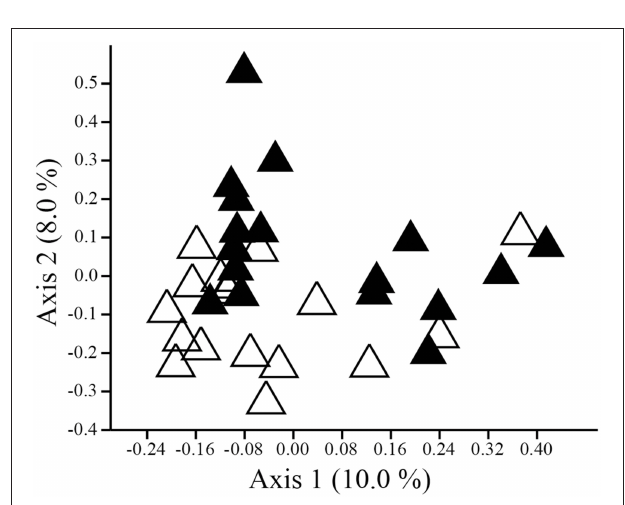
FIGURE 3 | PCoA plot illustrating separation in composition (Dice similarity) between the cloacal (open triangles) and uropygial gland (closed triangles) microbiota of adult